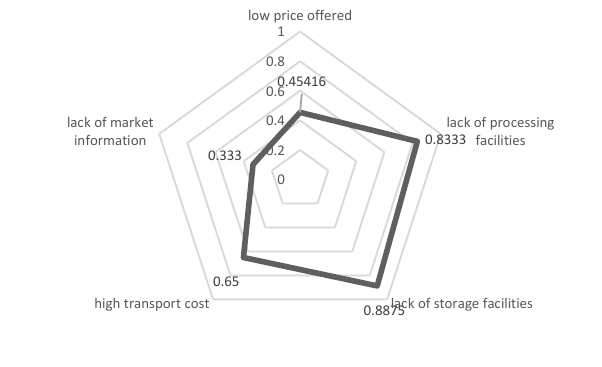
Figure 5: Problems faced during